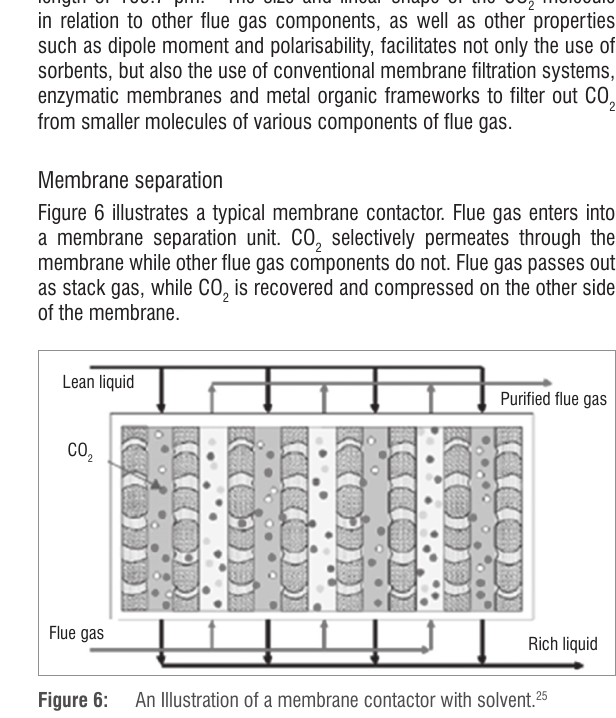
An Illustration of a membrane contactor with solvent.